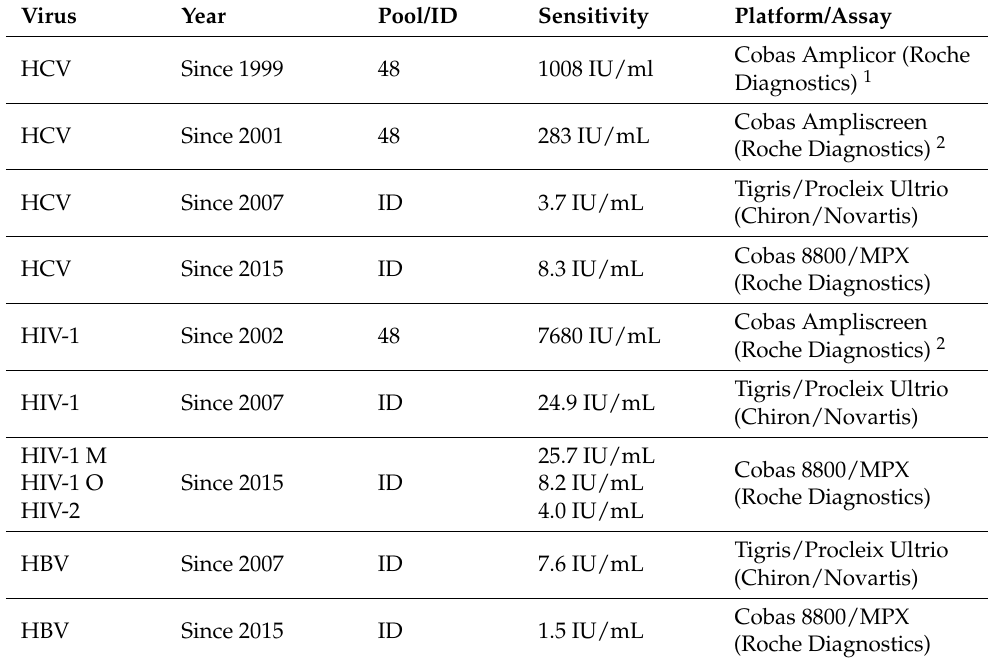
Table 1. Evolution of the testing algorithms and platforms for the NAT testing (data for IRB as an example for